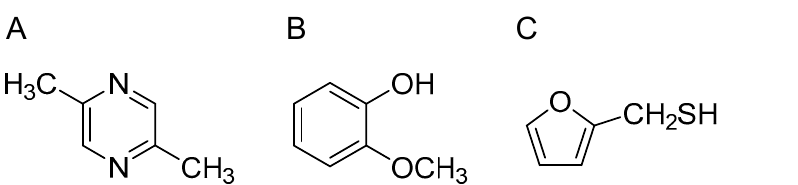
Figure 1. Chemical structures of 2,5-dimethylpyrazine ( A ), 2-methoxy phenol ( B ), and furfuryl mercaptan ( C ).